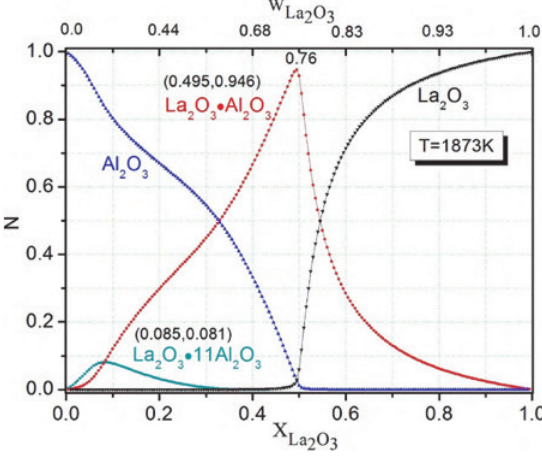
Fig. 1: The relationship between N i in La 2 O 3 -Al 2 O 3 slag and the mole fraction of La 2 O 3 at 1873